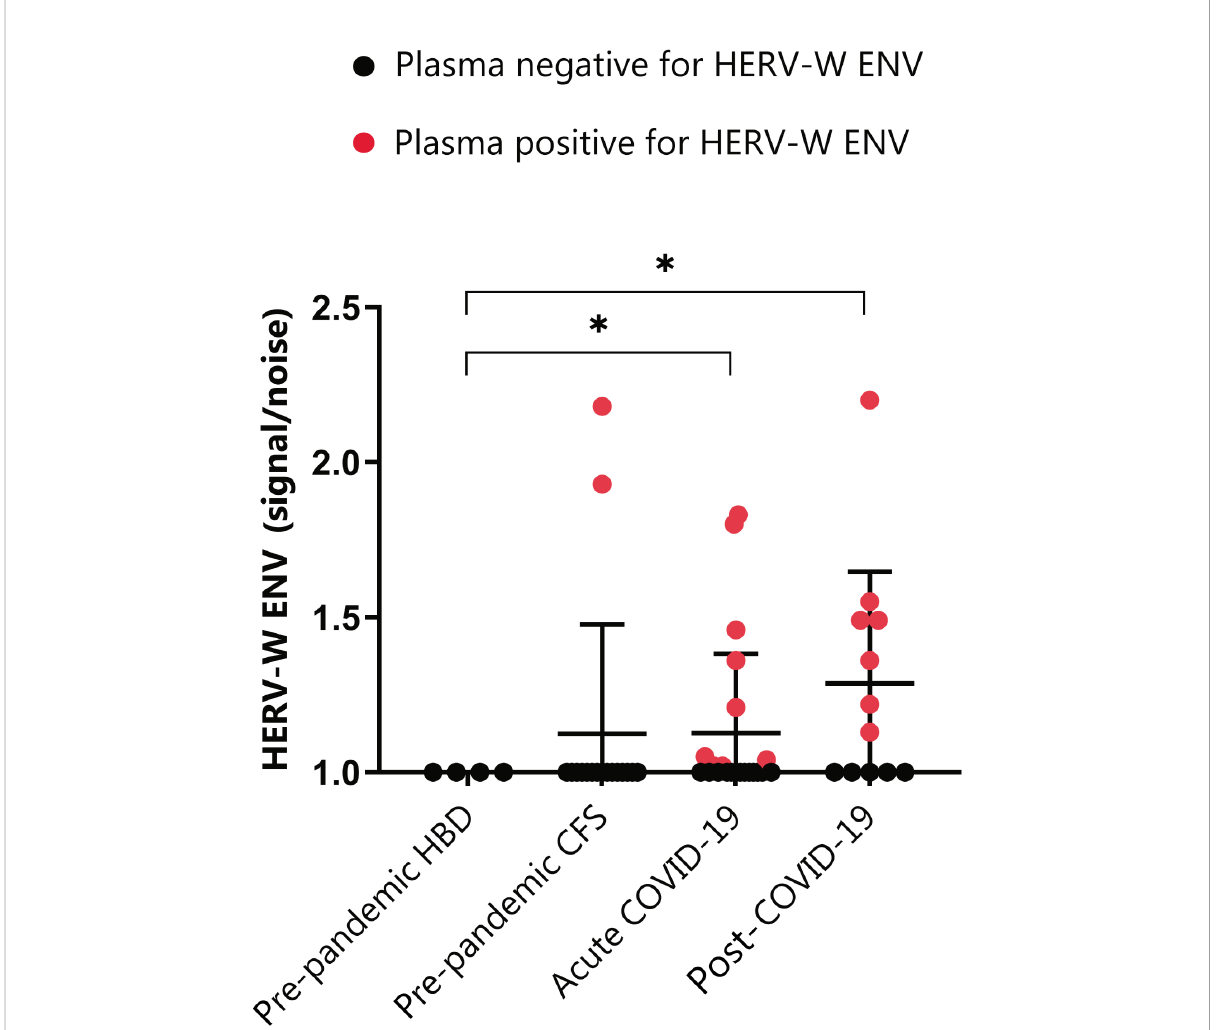
FIGURE 1 HERV-W envelope (ENV) antigenemia in pre-pandemic subjects (ppHBD, n=4), chronic fatigue syndrome cases (CFS, n=17), acute COVID-19 (n=22) and post-COVID-19 condition subjects (n=12). Levels of HERV-W ENV protein in plasma are shown normalized to noise (non HERV-W ENV speci fi c signal). Samples positive for HERV-W ENV protein antigenemia are labeled in red. *p < 0.05, based on t-test with Welch ’ s